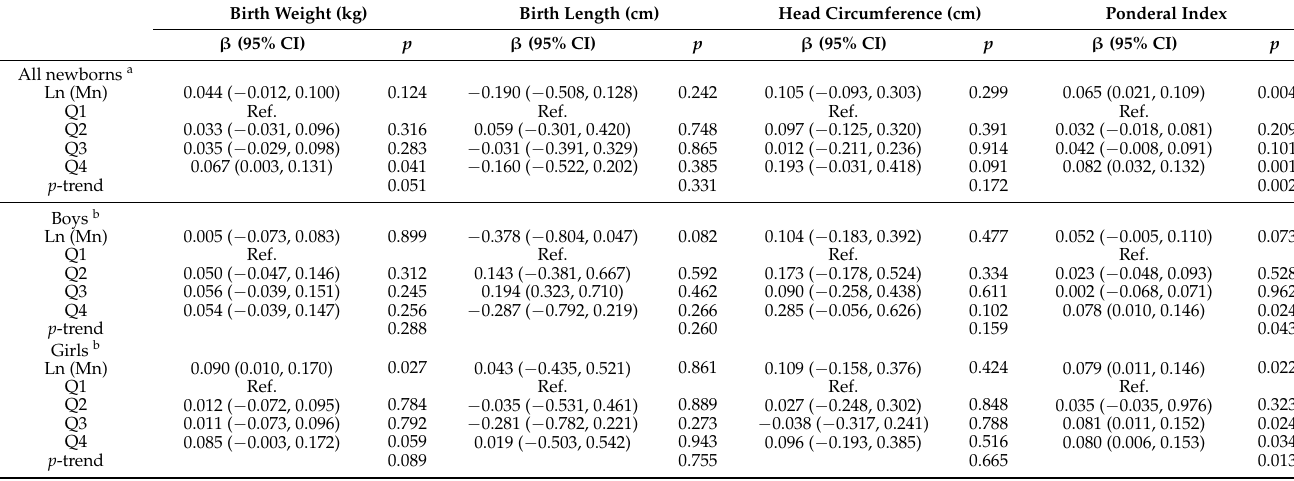
Table 2. Regression coefficients (95% CI) for associations between Mn concentrations in cord blood and birth